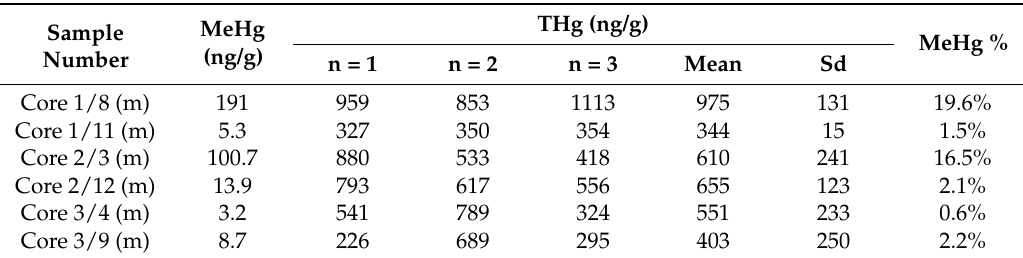
Table 2. MeHg and its accumulation percentage of